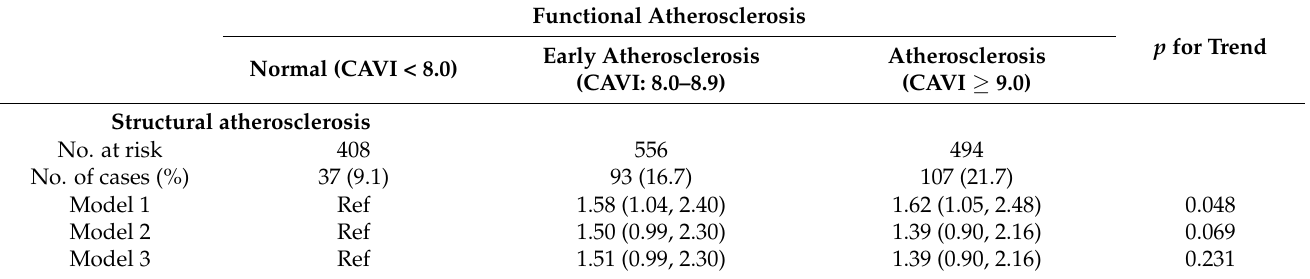
Table 2. Association between structural atherosclerosis and categories of functional